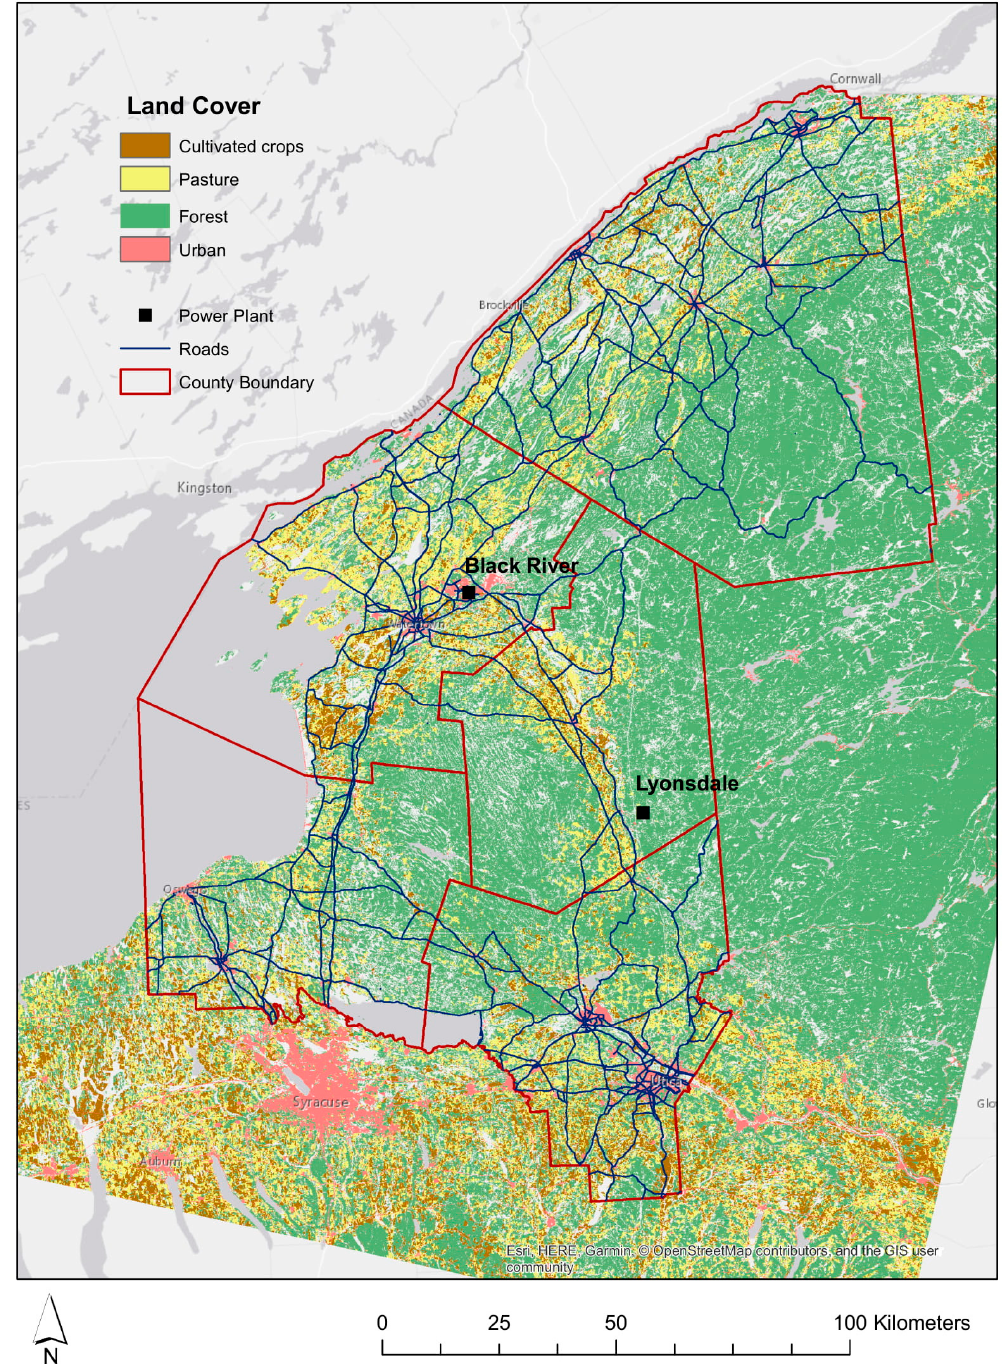
Figure 2. Five counties in central and northern New York State (Jefferson, Lewis, Oneida, Oswego, and St. Lawrence) where the spatial life cycle assessment (LCA) was conducted. The two power plants that have used willow as a portion of their fuel source shown as squares, Black River and Lyonsdale are owned by ReEnergy. Only primary roads are shown in the figure.